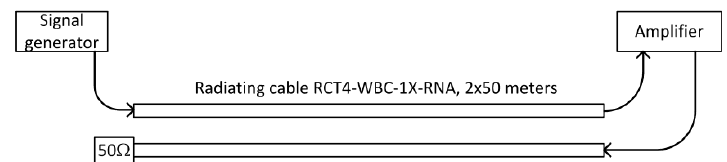
Figure 4. Measuring stand with two radiating cables for a case with return signal amplification.